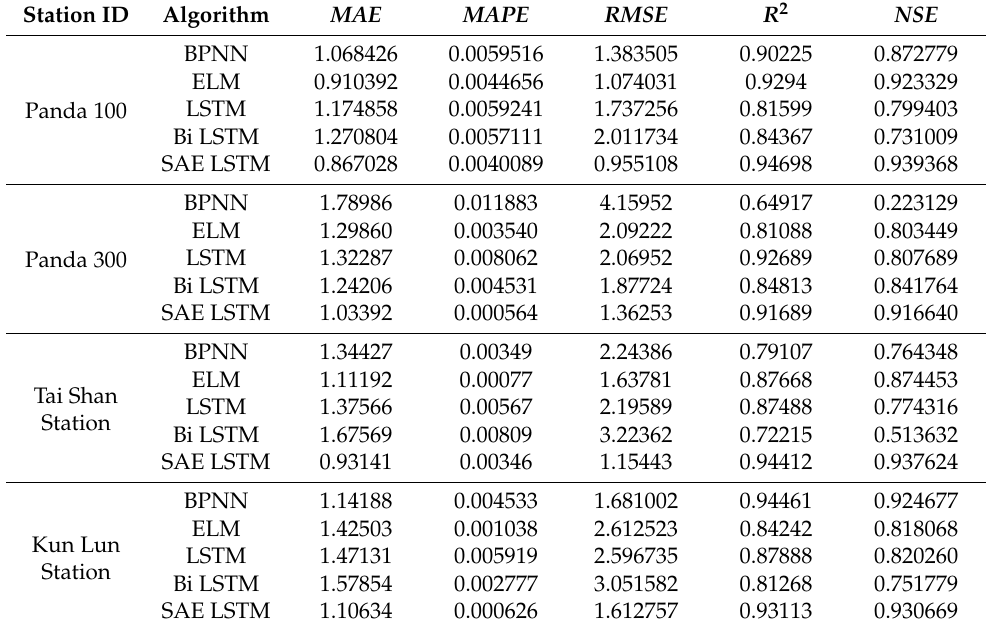
Table 4. One-hour temperature performance results from station Panda 100 to Kun Lun station.